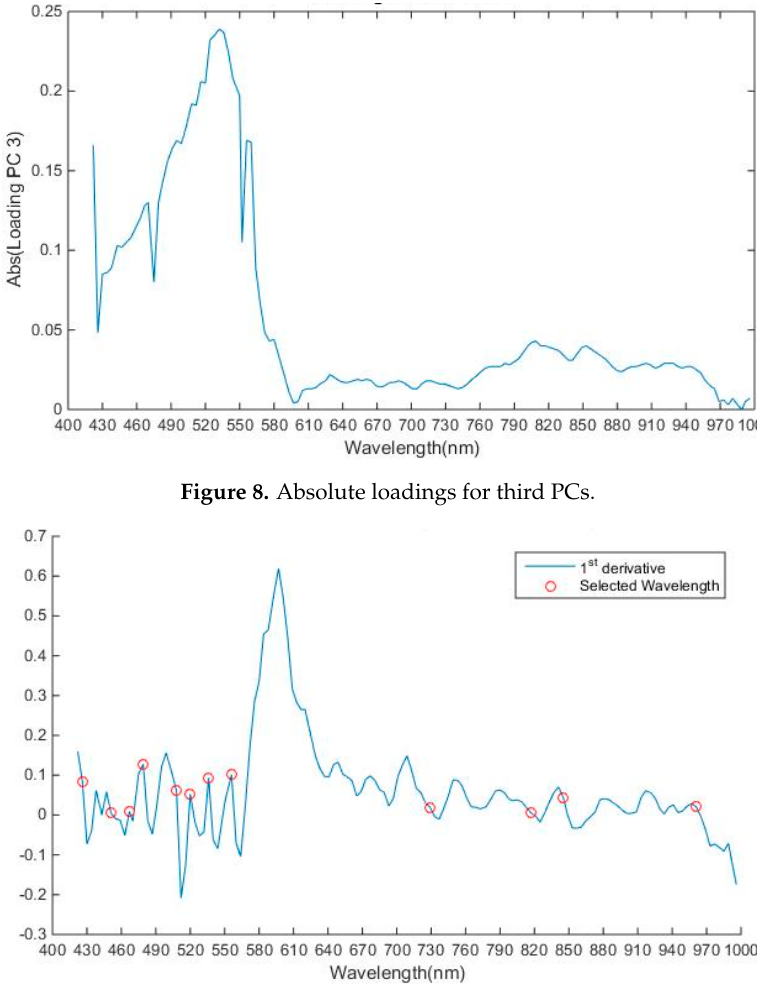
Figure 7. Absolute loadings for first PC.